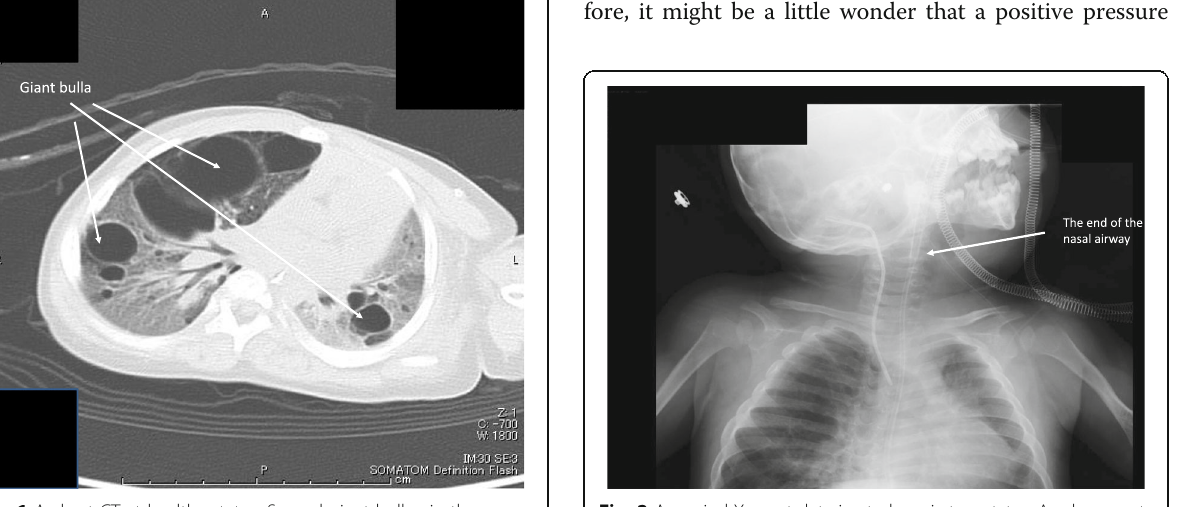
Fig. 2 A cervical X-ray at deteriorated respiratory status. A subsequent cervical X-ray revealed that the nasal airway was placed too